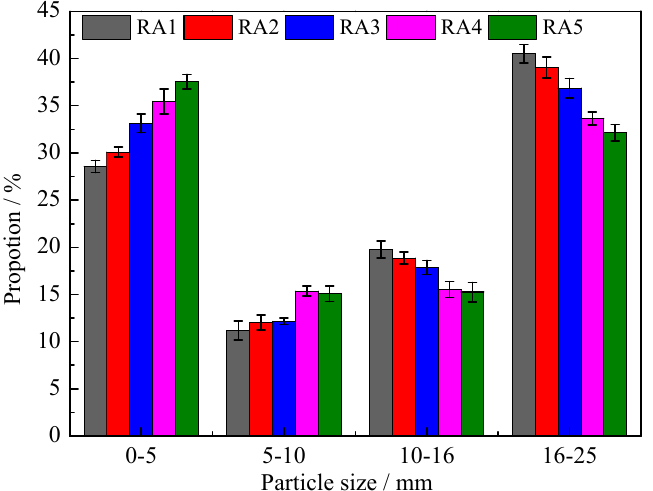
Figure 7. The particle size proportions of RA- i